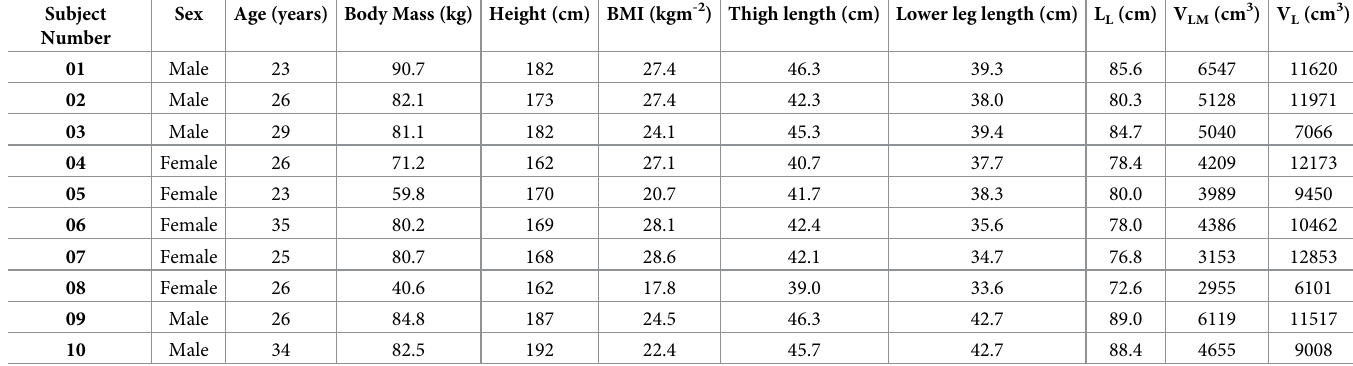
Table 1. Study participant information. Thigh length- the distance between the most proximal aspect of the greater trochanter of the femur, and the most distal aspect of the lateral femoral condyle. Leg length- the distance between the tibial plateau and the center of the ankle (tibiotalar) joint. L L —Total lower limb length. V LM —Total lower limb muscle volume (sum of volumes of the studied muscles). V L —Total lower limb volume (sum of muscle volumes plus fat, fascia and skin).